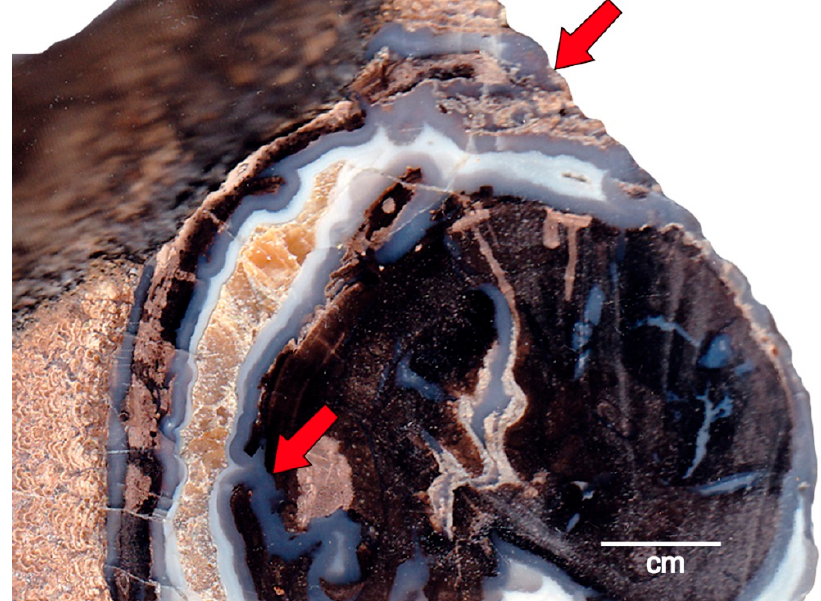
Figure 24. Transverse section of fossil wood, showing sinuous chalcedony-filled channels (arrows), and sparry calcite filling a crescent-shape peripheral zone.